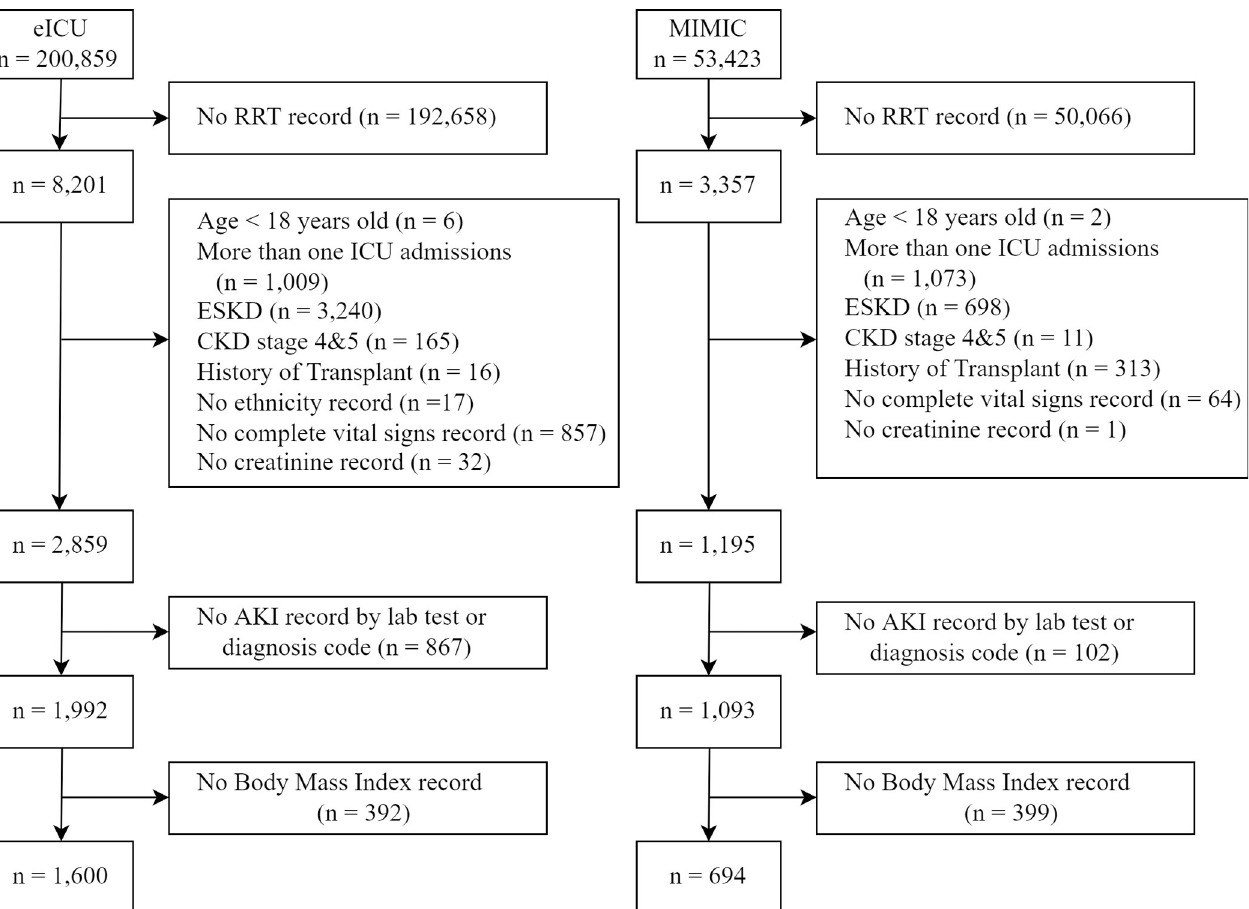
Fig 1. Participant flow diagram. n is patient unit encounter. Abbreviations: RRT, renal replacement therapy; ESKD, end-stage kidney disease; CKD, chronic kidney disease; ICU, intensive care unit; AKI, acute kidney injury.